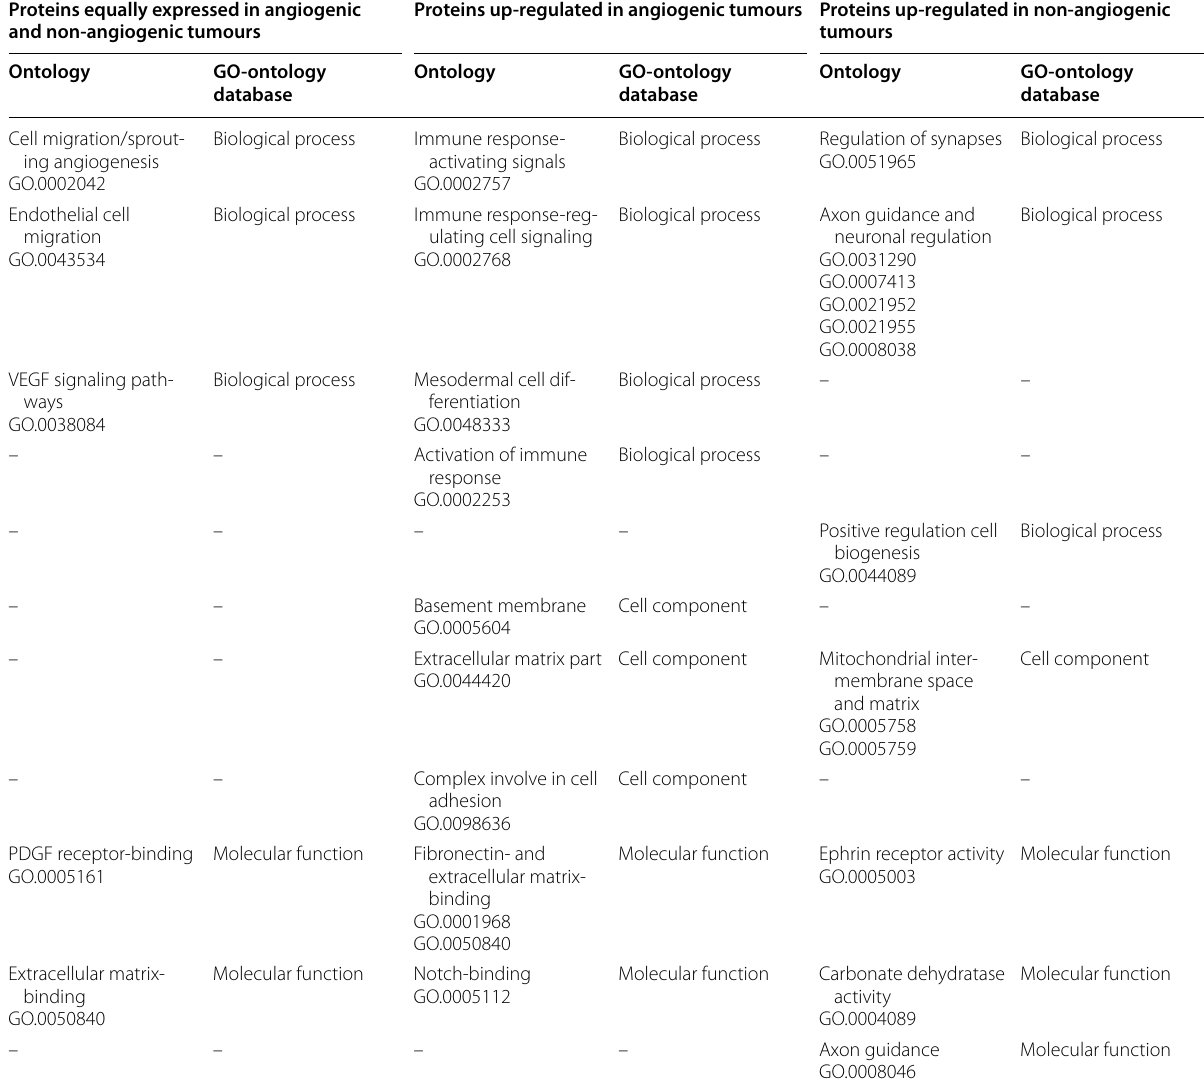
Proteins up-regulated in angiogenic tumours Proteins up-regulated in non-angiogenic